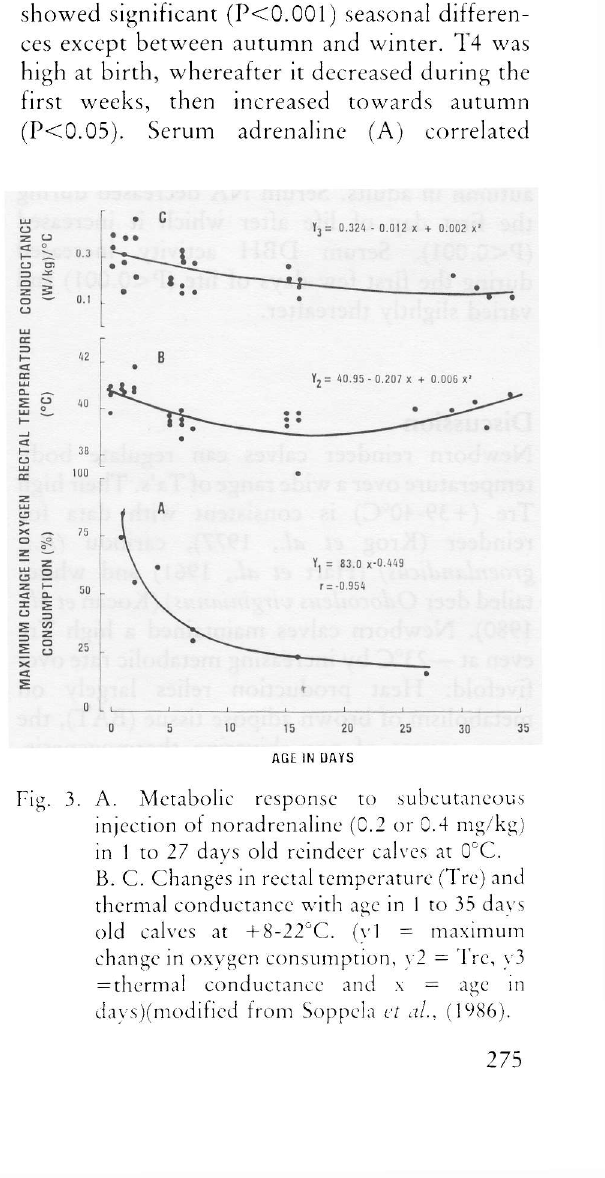
Fig. 2. Relation of thermal conductance to ambient temperature (Ta) in reindeer calves in three age classes, after 30 min exposure to a given Ta. The goodness of fit to polynomial regression was checked by an F-test after each increment of the polynomial degree, (y = thermal conductance and x = Ta)(modified from Soppela et al, (1986)).